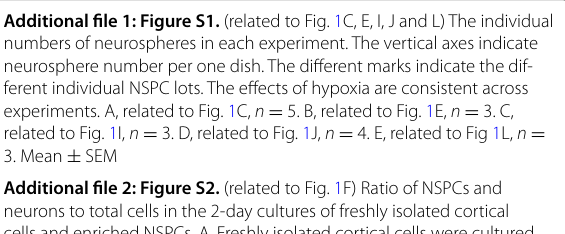
for 2 days under the normoxic or the hypoxic condition. Nestin + NSPCs and Tuj1 + neurons were observed at approximately the same percent- age (30%) under either condition. Mean SEM, n 3 (The 651 cells in ± = the control and the 655 cells in the hypoxia was counted in total.). B, Four-day enriched NSPCs were cultured for 2 days under the normoxic or the hypoxic condition. The ratio of nestin + NSPCs to the total number of cells under each condition was comparable (approximately 80 %). The percentage of Tuj1 + neurons under each condition was also comparable (approximately 3 %). Mean SEM, n 3 (The 1080 cells in the control and ± = the 955 cells in the hypoxia was counted in total.) Additional file 3: Figure S3. (related to Fig. 1F) GFAP expression in the enriched NSPC culture. The enriched NSPCs were cultured for 2-days in the presence of FGF2 under the normoxia or hypoxia. The cells cultured with LIF (80 ng/ml, ESGRO LIF, Merck ESG1106) and BMP2 (80 ng/ml, R&D Systems, 355-BM) under the normoxia was used as positive control for GFAP expression. Scale bar 100 μm = Additional file 4: Figure S4. Classification of neurosphere diameter (related to Figure 1J). The neurospheres were formed from the enriched NSPCs derived from E14 cerebral cortex. The 1,489 neurospheres under the normoxia and the 4,474 neurospheres under the hypoxia were measured. (A) Neurospheres with diameters smaller than 50 μm and those with diameters of 50 μm or larger were counted separately. (B) The ratio of neurospheres with diameters smaller than 50 μm and those with diameters of 50 μm or larger Additional file 5: Figure S5. Expression of markers for NSPC and neu- rons in the NSPC culture. The enriched NSPCs derived from E14 cerebral cortex were cultured for one day in the N2 and FGF2 supplemented medium. Then the cells were cultured for 4 days under normoxia or hypoxia. NeuN + neurons were significantly decreased by the hypoxic condition (Mean SEM, n 4, *** p 0.00028. The 3,641 cells in nor- ± = = moxia group and the 3,760 cells in hypoxia group were counted in total). Scale bar 100 μm = Additional file 6: Figure S6. (related to Fig. 2B) Representative micropho- tographs of neurospheres derived from enriched E14.5 NSPCs. NSPCs were cultured under the conditioned medium collected from normoxic- or hypoxic cortical cell culture. Scale bar 200 μm = Additional file 7: Figure S7. (related to Fig. 2B and E) Neurosphere num- ber in each samples. The vertical axes indicate neurosphere number per one dish. The different marks indicate the different individual NSPC lots. A, related to Fig. 2B, n 4. B, related to Fig. 2E, n 3. Mean SEM = = ± Additional file 8: Figure S8. (related to Fig. 2B) Neurosphere formation from enriched E14.5 NSPCs under the conditioned medium prepared from the absence cell culture. The medium component was not affected by hypoxic condition regarding neurosphere formation. Mean SEM, n 3 ± = Additional file 9: Figure S9. (related to Fig. 3A, B, C, H and I) The number of neurospheres in each samples. The vertical axes indicate neurosphere number per one dish. The different marks indicate the different individual NSPC lots. A, related to Fig. 3A, n 3. B, related to Fig. 3B, n 4. C, related = = to Fig. 3C, n 3. D, related to Fig. 3H, n 4. E, related to Fig. 3I, n 4. = = = Mean SEM ± Additional file 10: Figure S10. (related to Fig. 3A) Quantification of neurospheres from E11.5 NSPCs by administration of VEGF-A. Neurosphere formation from enriched E11.5 NSPCs was enhanced by exogenous VEGF-A like as the case of E14.5 NSPCs. Mean SEM, n 3, * p 0.017 by ± = = one-sided test, p 0.059 by two-sided test = Additional file 11: Figure S11. (related to Fig. 3B) Effect of SU1498 on neurosphere formation in the presence of VEGF-A. Mean SEM, n 4 in ± = 0, 0.35, and 0.7 μM of SU1498; n 3 in 1.4 and 2.8 μM of SU1498; n 2 in = = 0.175 μM of SU1498; a p 0.0055, b p 0.063, c p 0.0070, d p 0.0027, e = = = = p 0.015, f p 0.043 = = Additional file 12: Figure S12. Full-length gel images of Fig. 3D, F. A. Full-length gel image of Fig. 3D. B, C. Full-length gel image of Fig. 3F. The yellow dotted squares indicate the cropped area. The VEGF-A gel image of B was inverted horizontally in Fig. 3F. M, 1 kb Plus DNA Ladder (New England BioLabs, N3200); N, normoxia; H,